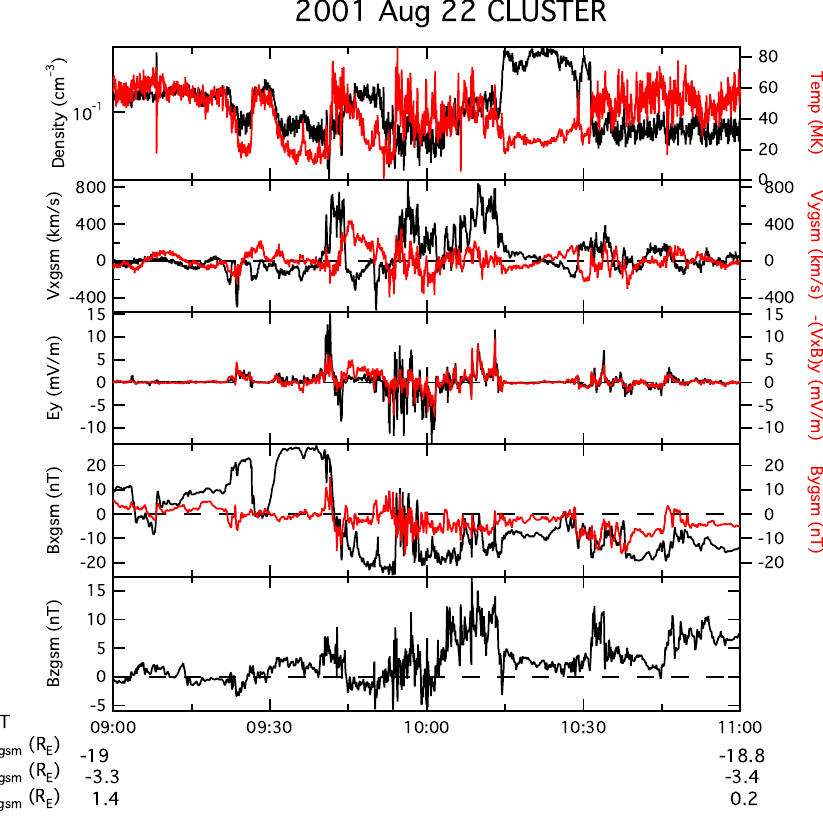
Fig. 3. Overview of Cluster observations during the substorm on 22 August